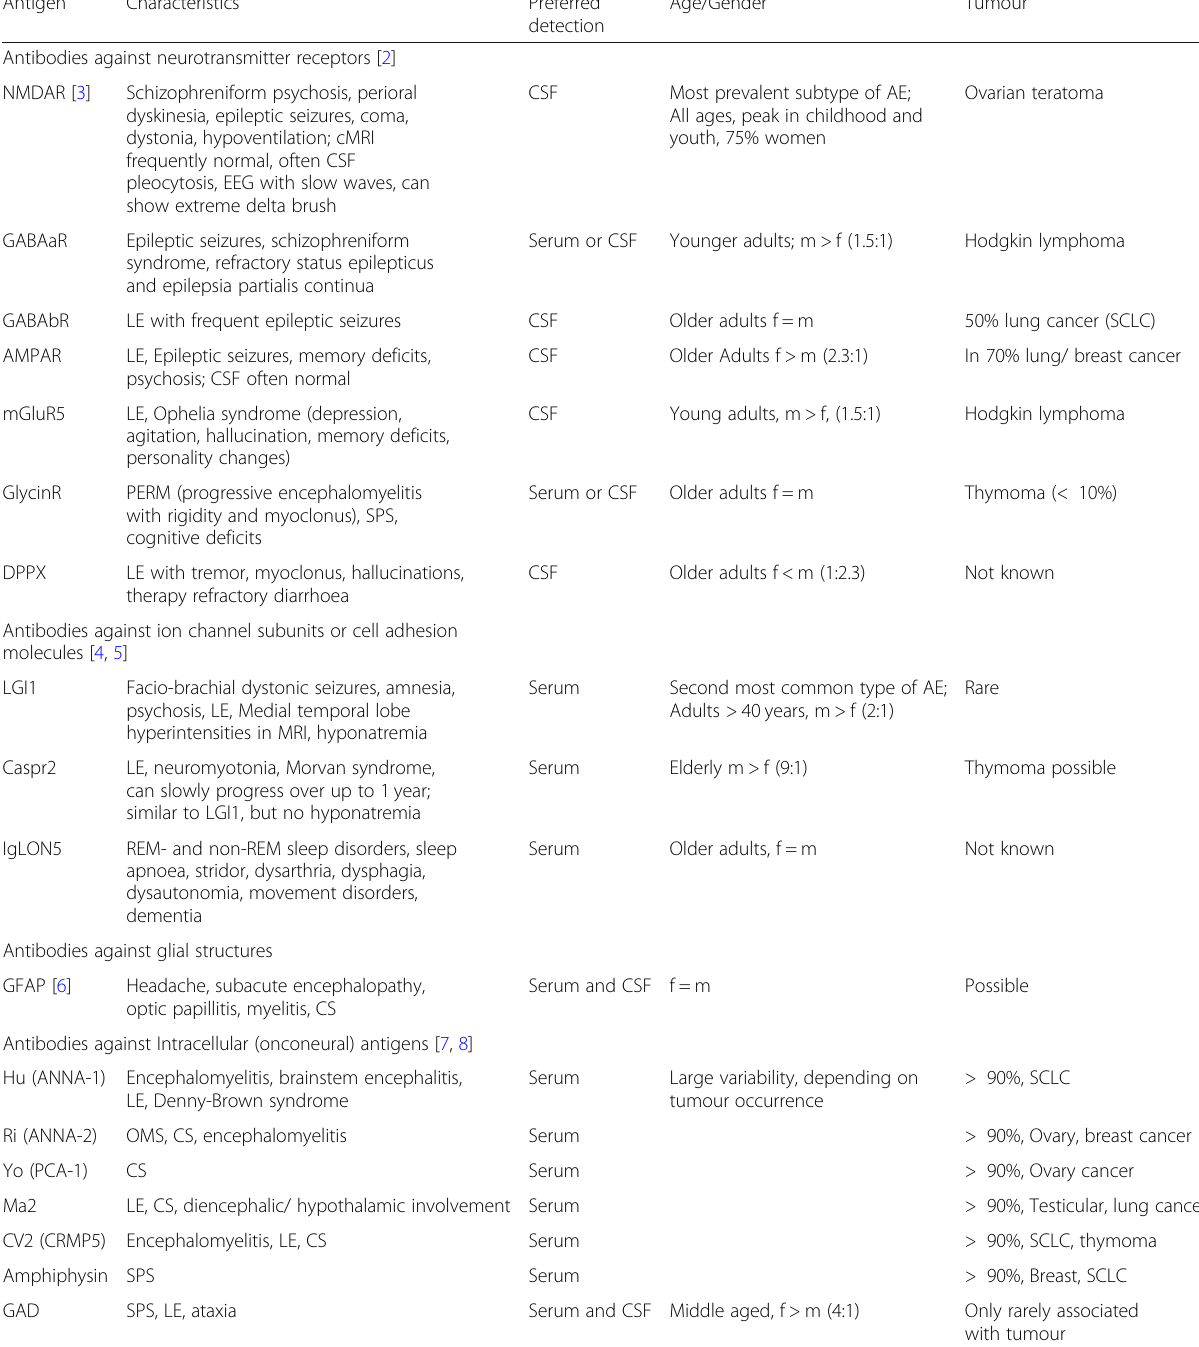
Table 1 Most important antibodies and clinical syndromes Antigen Characteristics Preferred